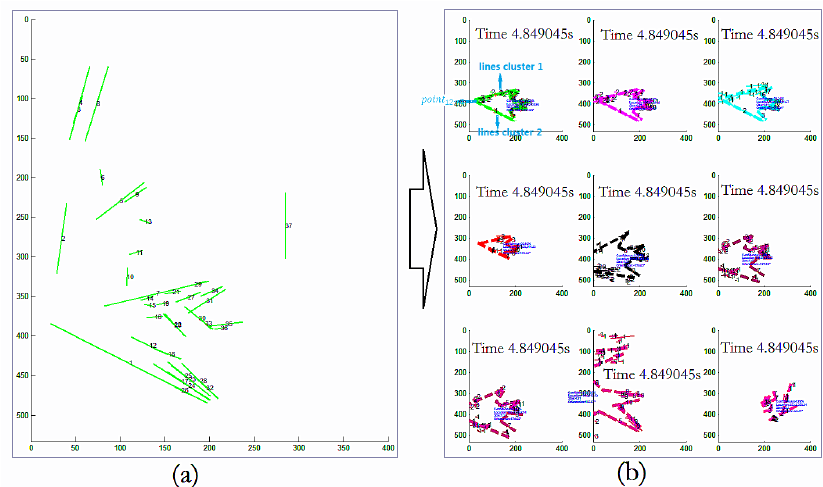
Figure 7. An example for object estimation by verification. For lines in ( a ), the location, scale, and orientation of the object could be verified through searching path. ( b ) The top nine paths satisfying the geometric constraints of Γ were found. Each path represents an estimation of the object. It is obvious that our method not only efficiently detected the object but also estimated the object’s location, scale, and orientation.